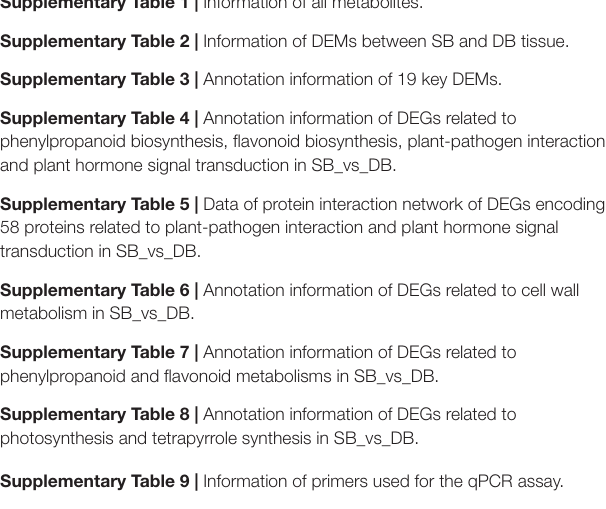
Supplementary Figure 4 | Schematic diagram of formation mechanism of SB tissue. Supplementary Table 1 | Information of all metabolites. Supplementary Table 2 | Information of DEMs between SB and DB tissue. Supplementary Table 3 | Annotation information of 19 key